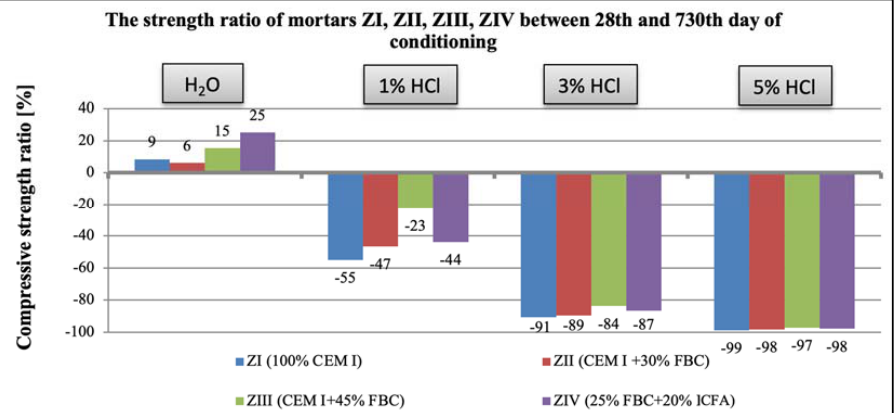
Figure 33. Compressive-strength ratio of mortars ZI, ZII, ZIII, and ZIV between the 28th and 730th day of conditioning in water and in 1%, 3%, and 5% solutions of hydrochloric acid.